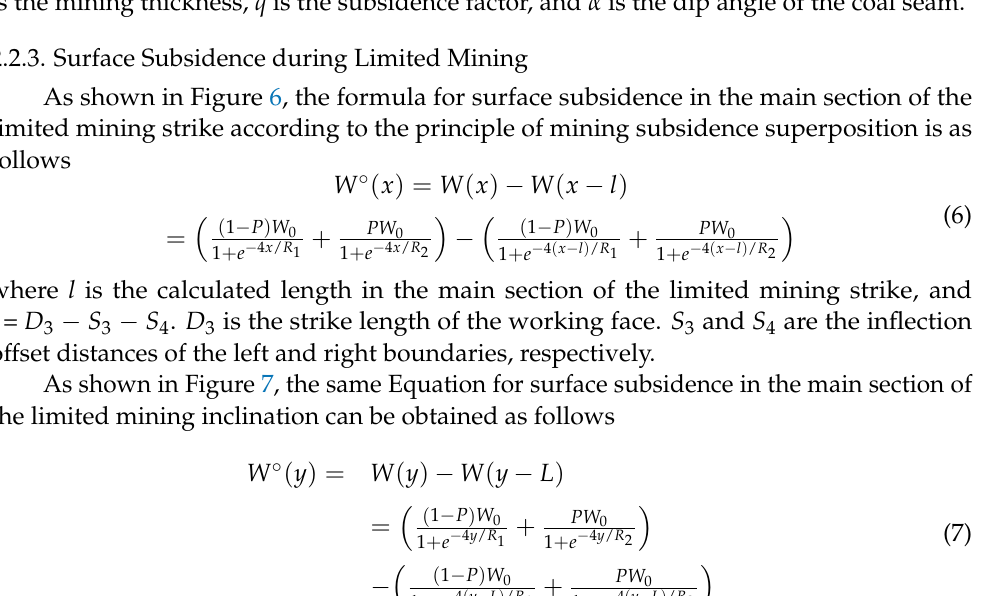
Figure 6. Surface subsidence in the main section of the limited mining strike.